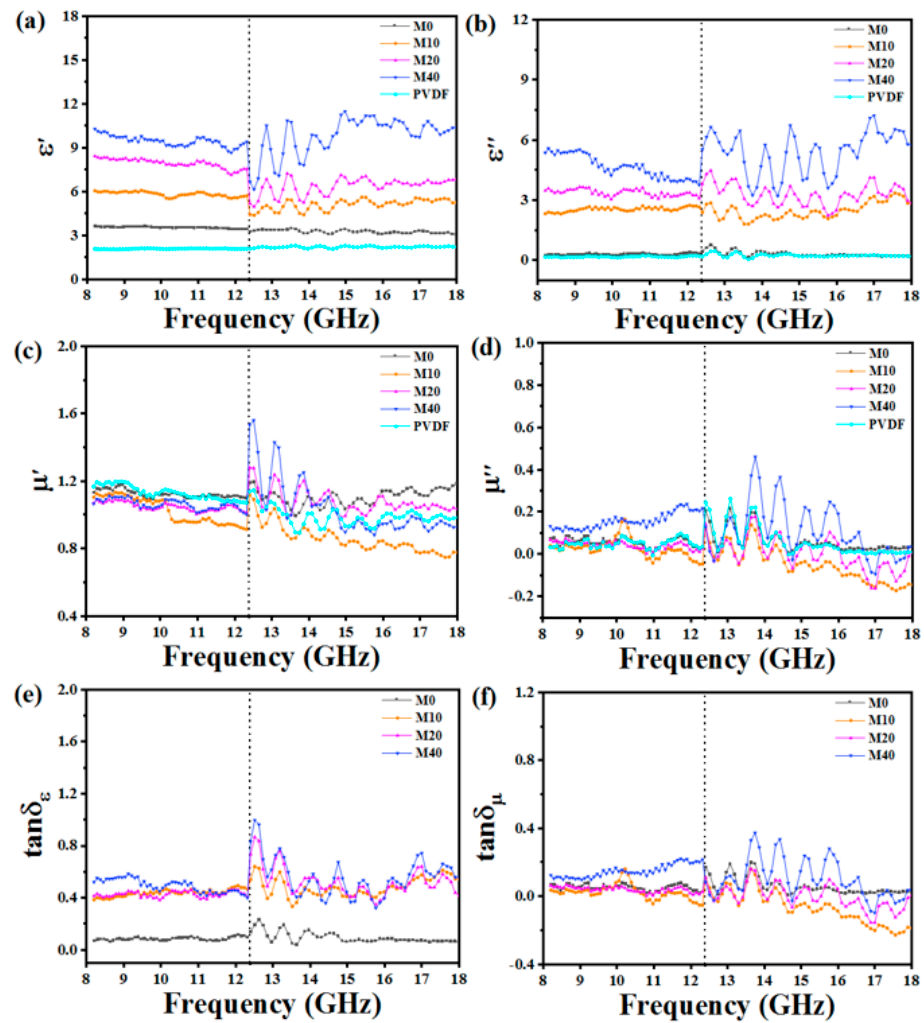
Figure 7. ( a ) Real ( ε ׳ ) and ( b ) imaginary ( ε ׳׳ ) parts of permittivity, ( c ) real (µ ׳ ) and ( d ) imaginary (µ ׳׳ ) parts of permeability, ( e ) dielectric (tan δ ε ) and ( f ) magnetic (tan δ µ ) loss tangents of all samples at 8.2–18 GHz frequency.